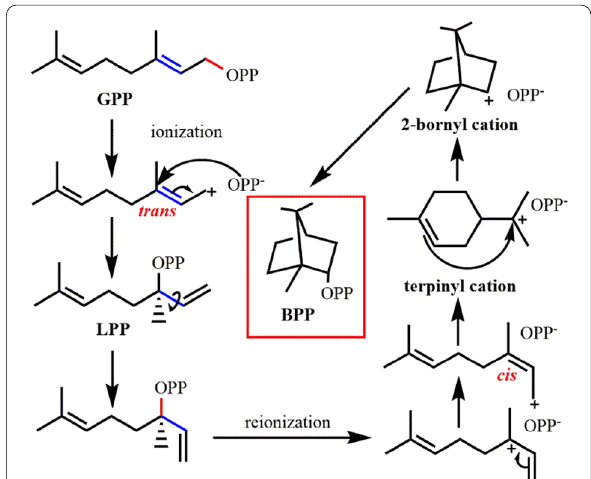
Fig. 5 Cyclization mechanism of bornyl diphosphate synthase. GPP geranyl diphosphate, LPP (3 R )‑Linalyl